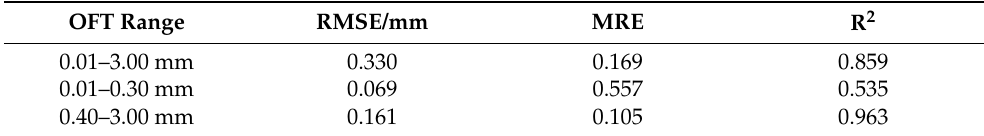
Table 4. Evaluation of inversion accuracy (2 August,